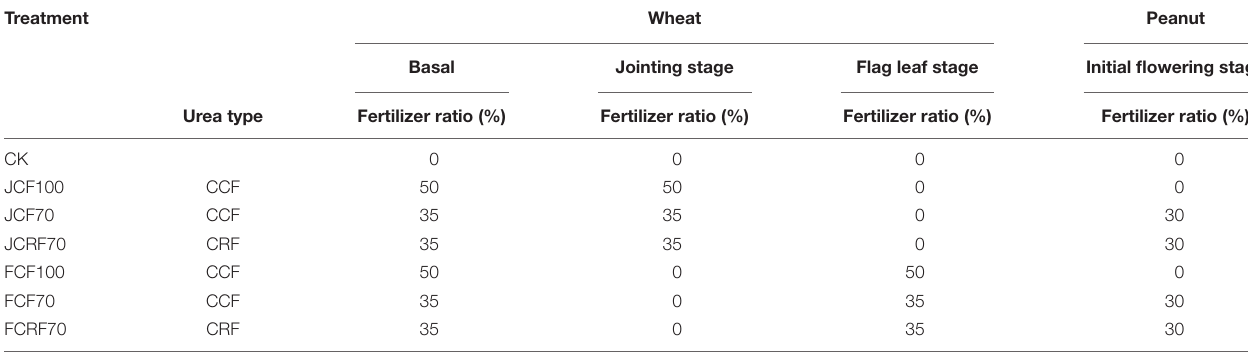
TABLE 2 | N application stages and fertilizer ratios during the wheat and peanut seasons. Treatment Wheat